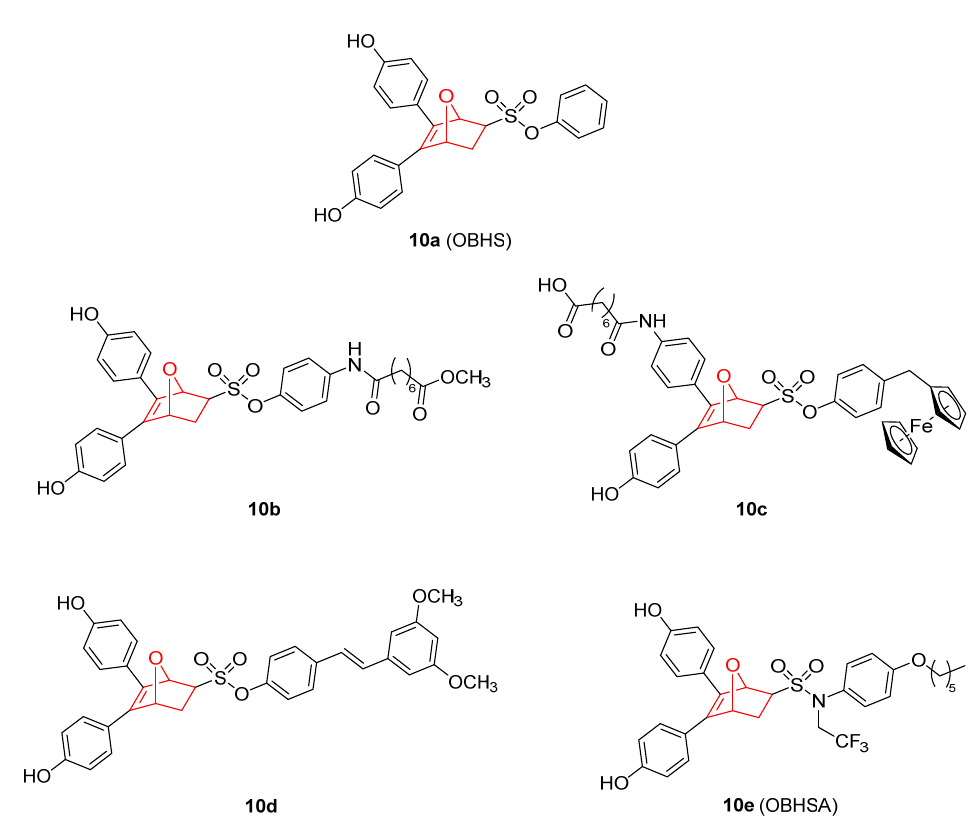
Figure 10. OBHS derivatives with estrogen receptor agonist activity [133–138].